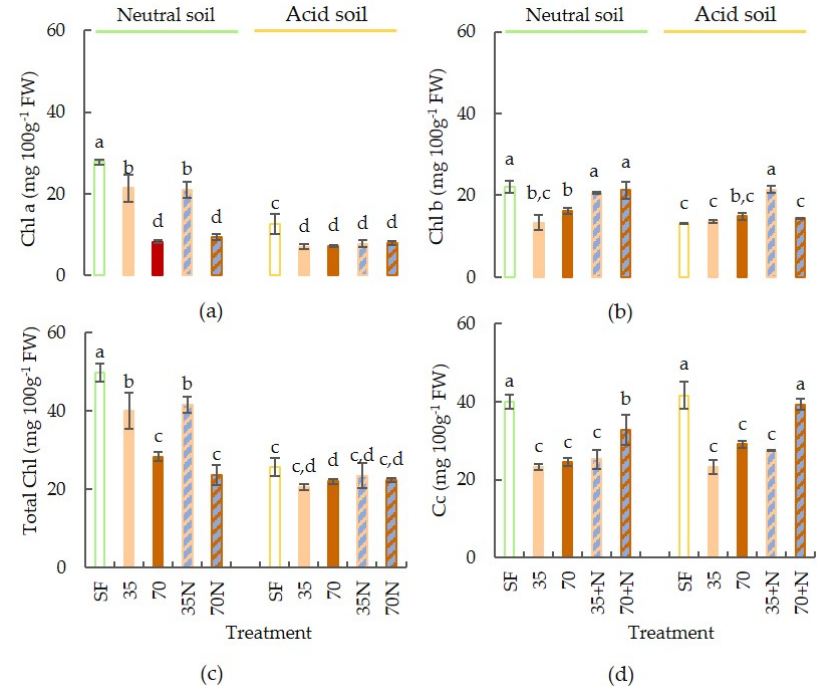
Figure 7. Effects of soil and MSWC rates supplemented or not with inorganic nitrogen on levels of photosynthetic pigments [chlorophyll a ( a ), chlorophyll b ( b ), total chlorophyll (Chl a+b) ( c )], and carotenoids ( d ). Note: FS—fertilized soil; 35—35 t MSWC ha − 1 ; 70—70 t MSWC ha − 1 ; 35 + N—35 t significantly different at p < 0.05. Each bar represents the mean of six replicates, while the error bars represent ±1SE.